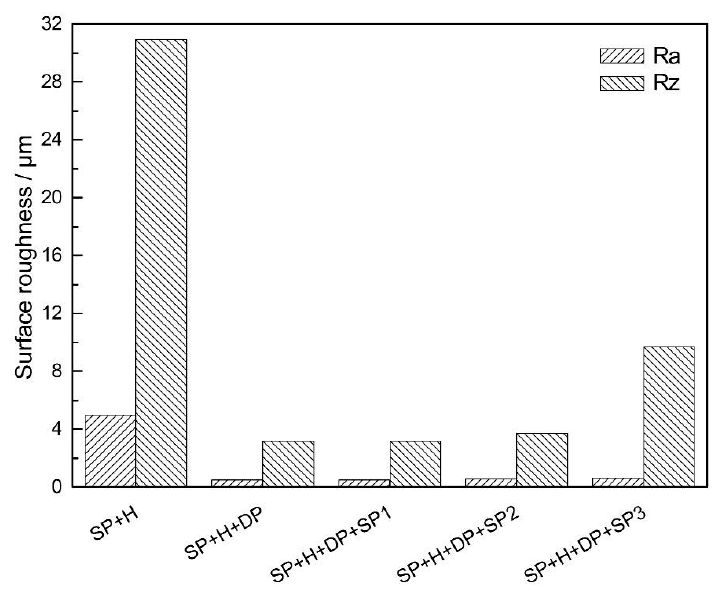
Figure 5. Surface roughness values of specimens with different surface treatments.